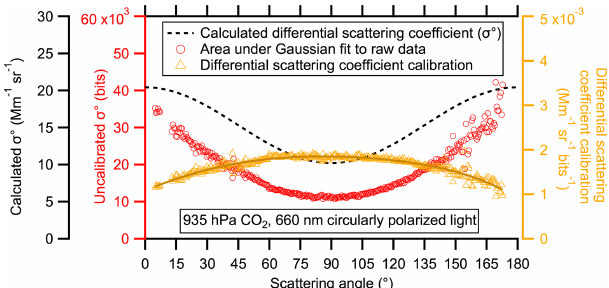
Figure 5. Differential scattering coefficient calibration for 935hPa of CO 2 using circularly polarized, 660nm light. The differential scattering coefficient calibration (dark orange line) is a sixth-order polynomial fit to the ratio of calculated σ ◦ (black dotted line, Mm − 1 sr − 1 ) to the area of the Gaussian fit to the background- subtracted image (orange triangles,